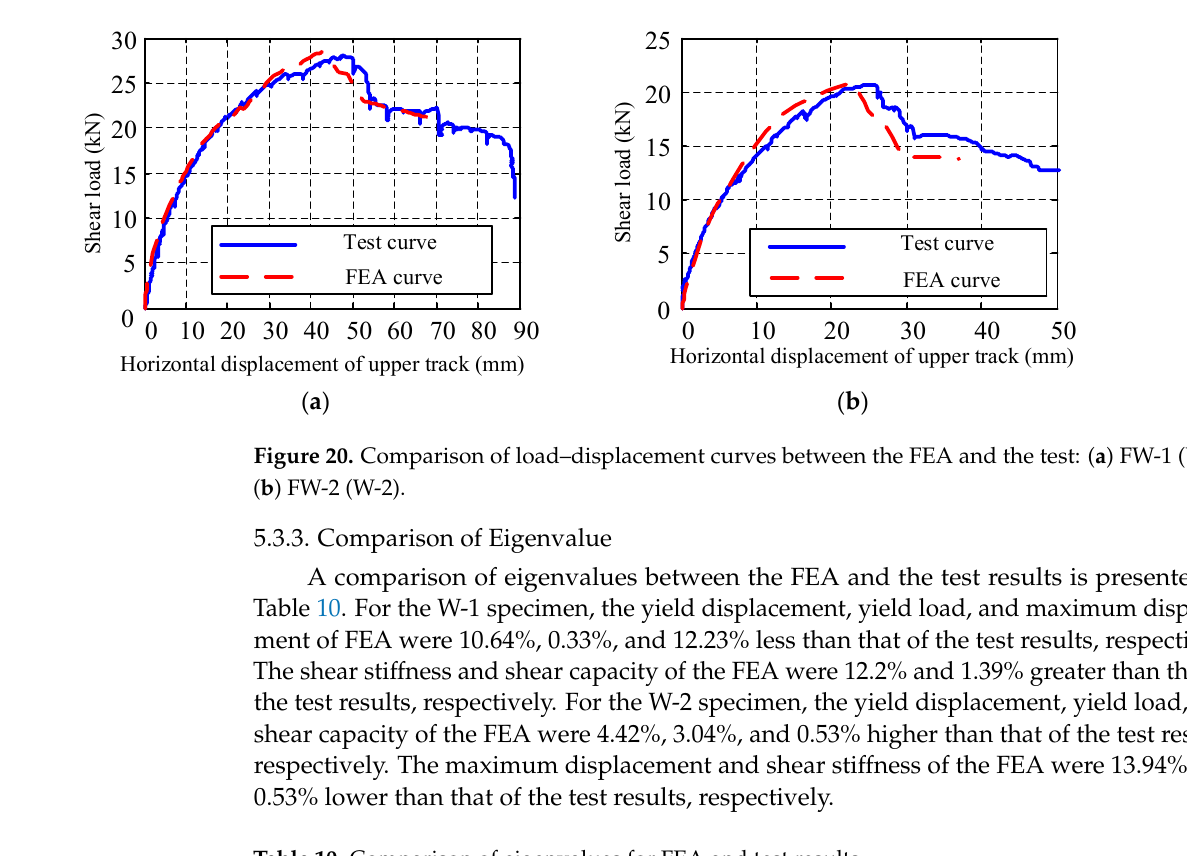
( b ) Figure 19. Comparison of failure modes between the FEA and the test results for specimen FW − 2 (W − 2): ( a ) FEA result, ( b ) test result. 5.3.2. Comparison of Load–Displacement Curves